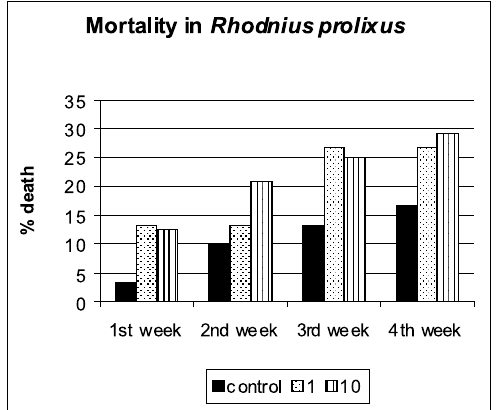
Fig. 3 – Toxicity of oleanolic acid ( 1 ). Concentrations in µ g/ml.